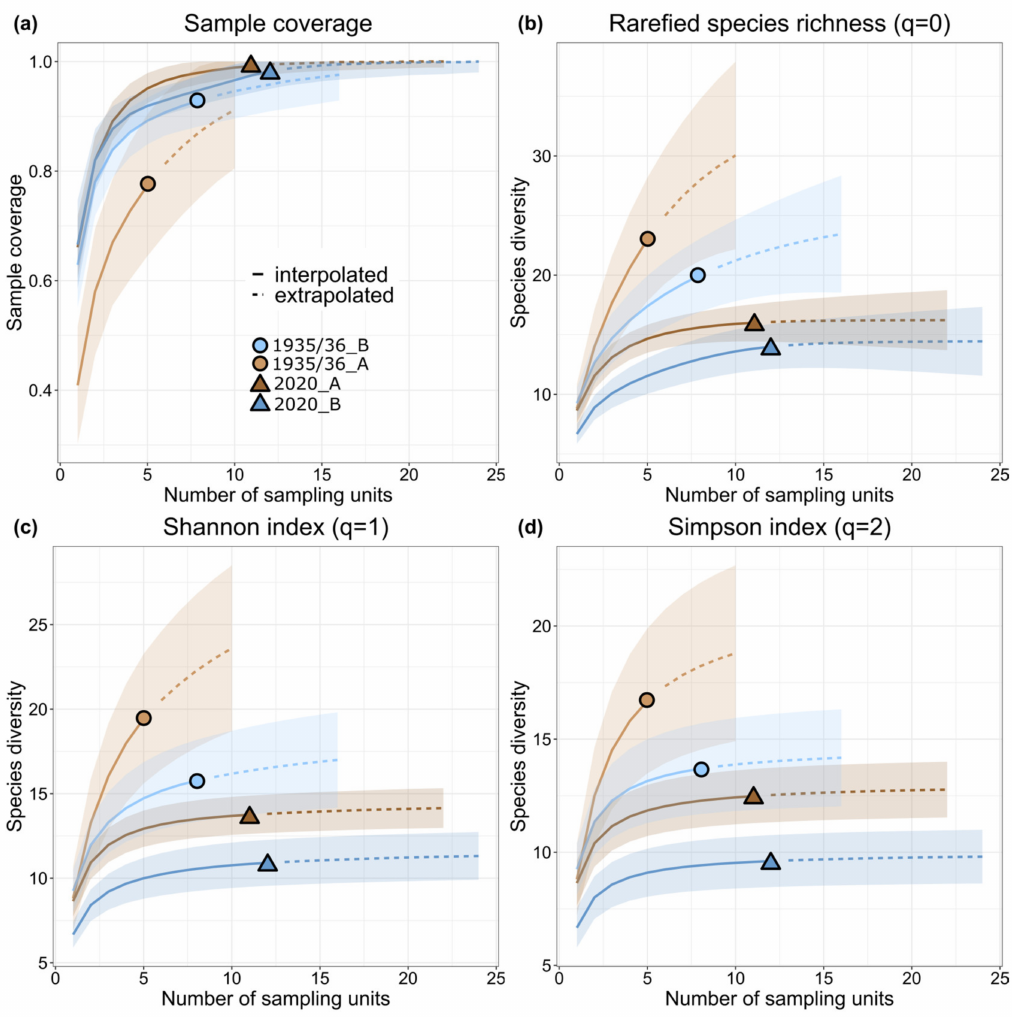
Figure 5. ( a – d ) Sample unit-based diversity estimates plotted as integrated curves for each sampling period (1935/1936 = circles, 2020 = triangles) and elevation clusters (A = brown, B = blue); ( a ) Sample coverage of each group and ( b – d ) three integrated diversity curves representing Hill numbers (q): the rarefied estimates ( b ) for species richness (q = 0), ( c ) for Shannon’s diversity index (q = 1), and ( d ) for the inverse Simpson’s index (q = 2). Colors and shapes represent the respective sampling period and elevation cluster. The interpolation estimates are represented by solid lines and the extrapolation estimates by dashed